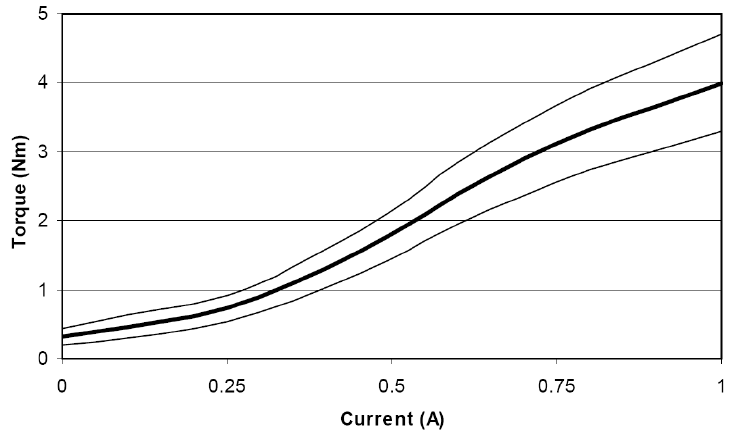
Figure 22. Typical torque-current curve of the LORD RD-2087-01 MR rotary damper.